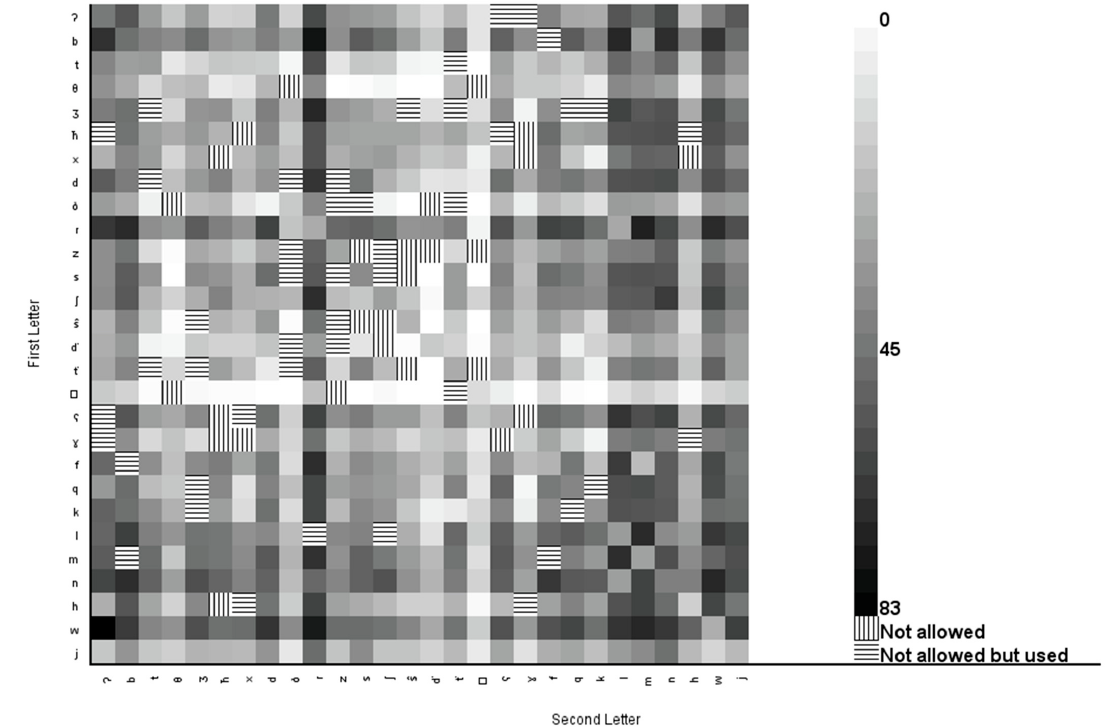
Figure 4. Arabic Roots Bigram